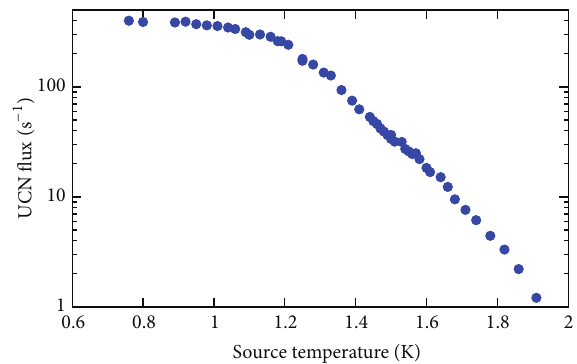
Figure10:UCNcountrateversusthetemperatureofHe-II.Thecold neutron beam constantly passes through the source and the UCN valve is opened periodically.